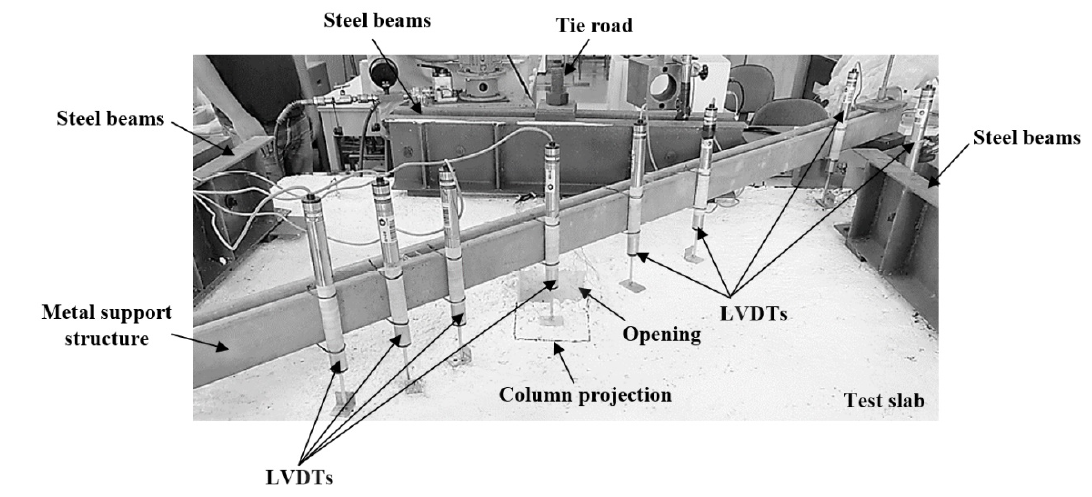
Figure 8. Setup of digital indicators for measuring vertical displacements.